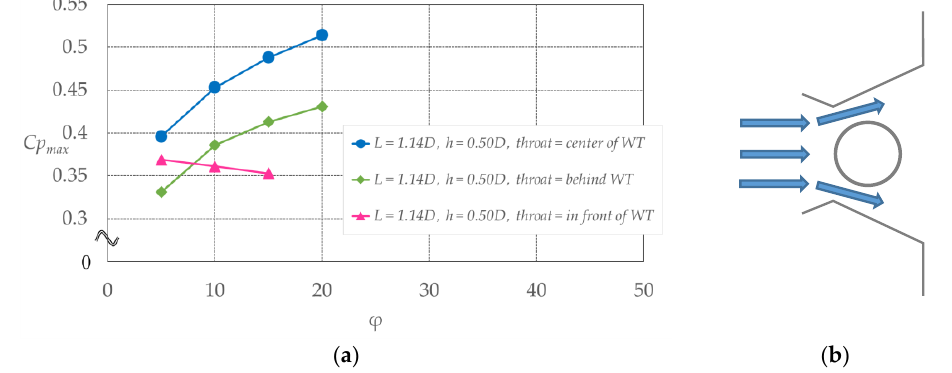
Figure 10. ( a ) Maximum power coefficient Cp max of wind turbines vs. semi-open angle of the diffuser φ; ( b ) Inferred flow when the throat of the wind lens is located in front of the wind turbine. Refer to Figure 2 for h , D , and L .